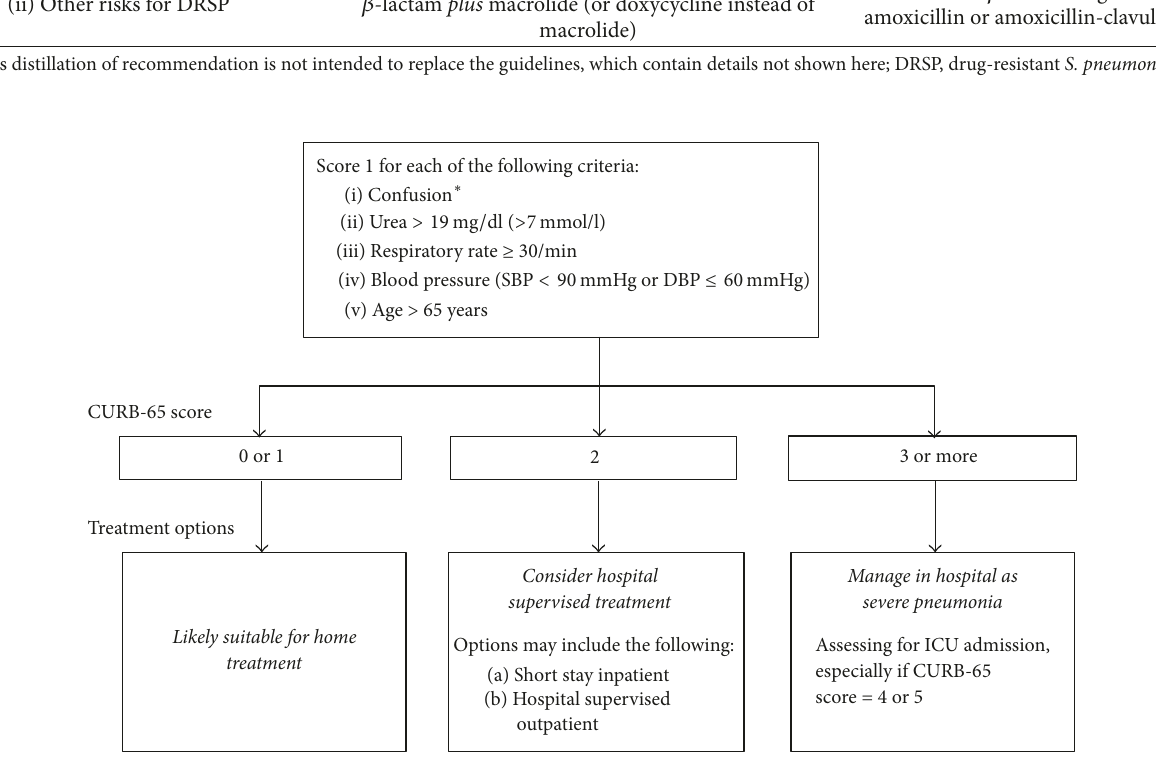
include bacteremia, sepsis, empyema, pericarditis, respira- tory failure, and